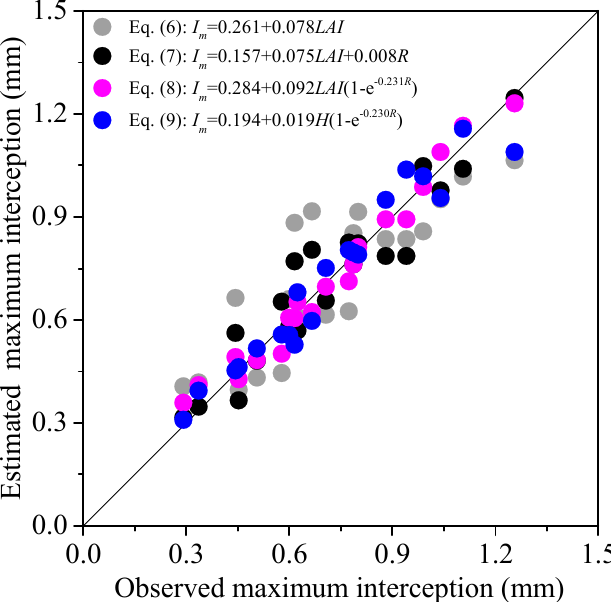
Figure 6. Observed and estimated maximum interception for four equations. I m is the maximum interception, LAI is leaf area index, R is sprinkling intensity, and H is plant height. The diagonal line indicates the ratio of 1:1.